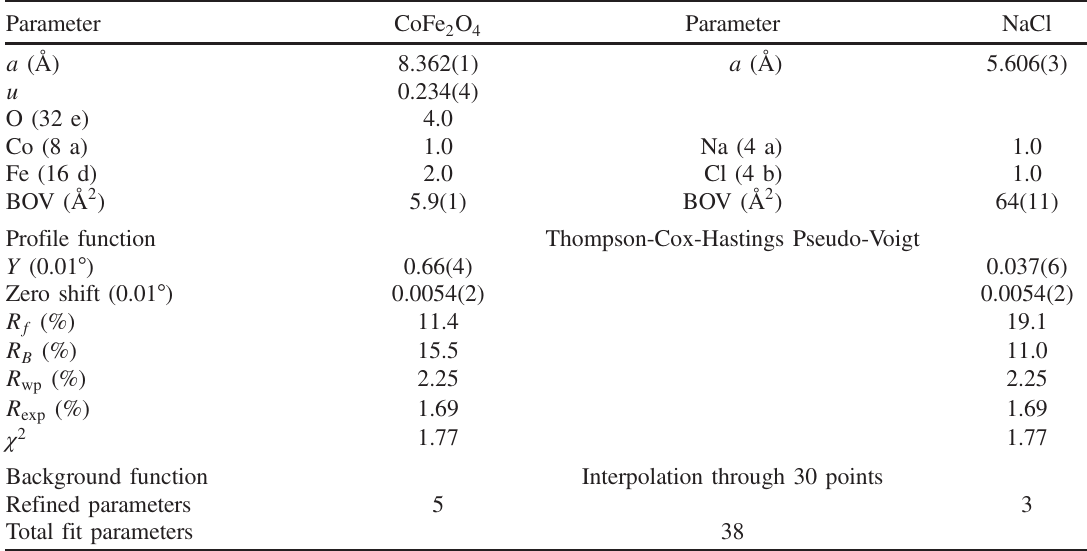
TABLE I. Rietveld refinement results for the CoFe 2 O 4 main phase ( Fd summarizing the lattice parameters a , the oxygen site u , the occupancy parameters (not refined), the overall isotropic displacement BOV, and the Lorentzian broadening Y